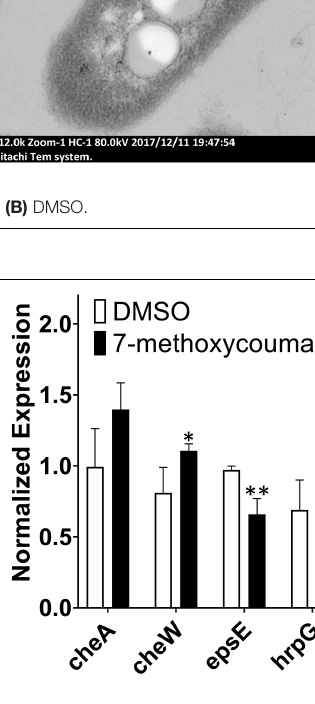
the disease index of DMSO treatment was 0.53, 2.03, 3.00, and 3.58 at 6, 8, 10, and 12 days, respectively.